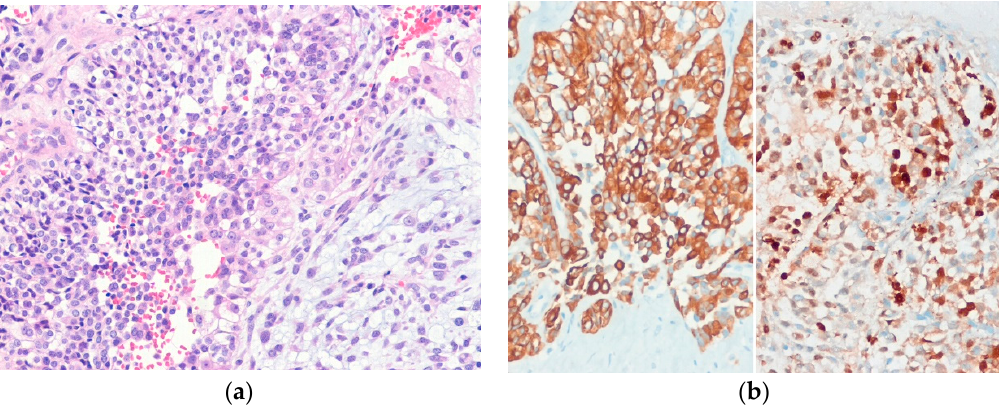
Figure 8. Myoepithelial carcinoma. ( a ) The tumor cells have cohesive epithelioid appearance with nuclear atypia and prominent nucleoli; ( b ) The tumor cells are positive for cytokeratin (AE1/AE3) (left) and S100 protein (right) (H&E stain. original magnification 100× ( a ); cytokeratin (AE1/AE3) and S100 protein immunostain, original magnification 200× ( b